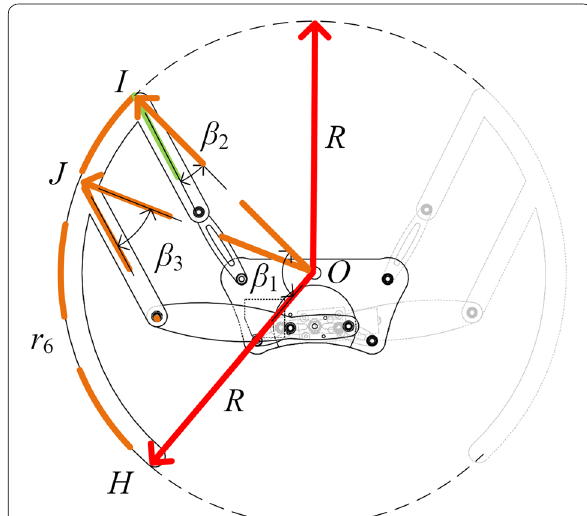
Figure 4 Structural design of two modes